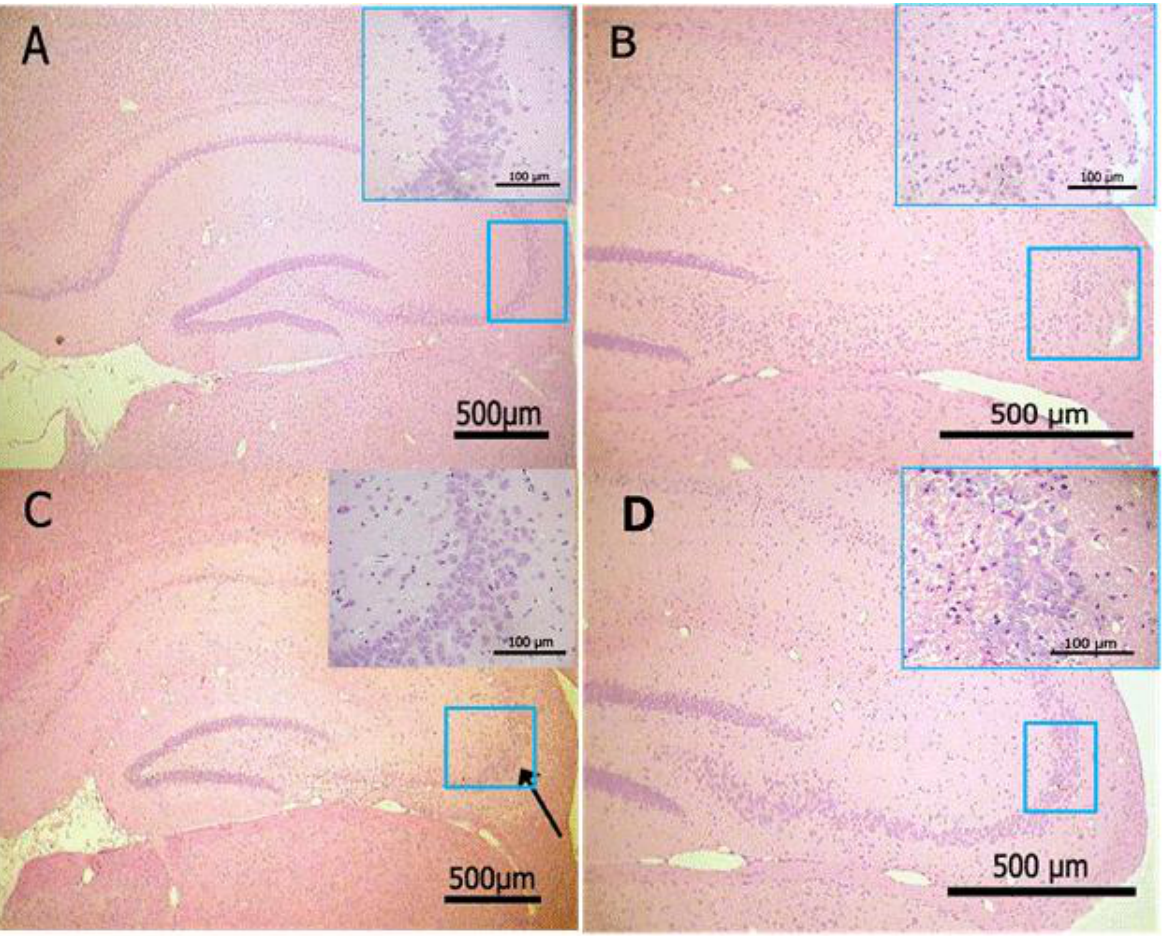
FIGURE 4 . H-E. (A) Normal dorsal hippocampus. CA3 region amplified. (B) Ischemia stroke in the hippocampus 7 days after occlusion. CA3 region amplified with pyramidal pyknotic neurons. (C) Neuro-EPO IN protects sector CA3 of the dorsal hippocampus and CA1 is not protected. Arrow: conservation of CA3 neurons. (D) EPO IP protects sector CA3 of the dorsal hippocampus and CA1 is not